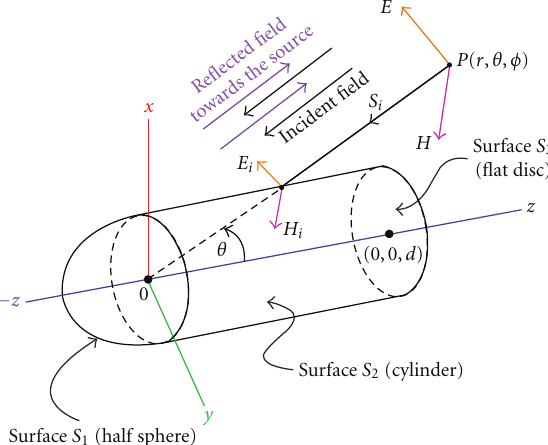
Figure 1: Three dimensional geometry of the shell-shaped projec- tile, and the coordinate system along with incident field